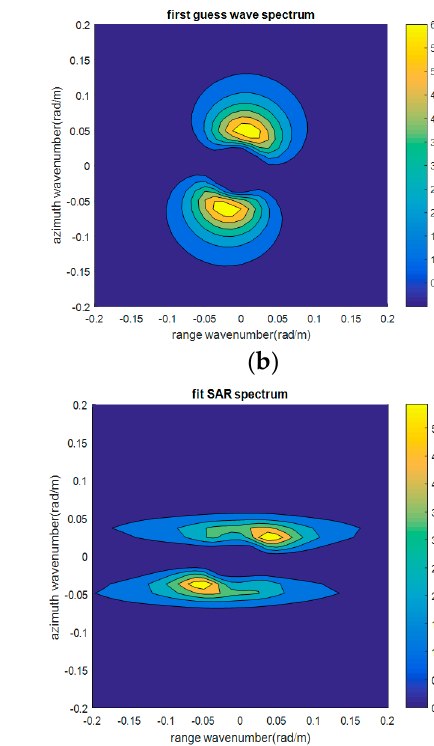
( d ) Figure 11. SAR-1 : Max Plank Institute (MPI) algorithm inversion results as follows: ( a ) Observed SAR spectrum (after horizontal flip), ( b ) first guess PM wave spectrum, ( c ) fit PM wave spectrum, and ( d ) fit SAR spectrum. As can be seen from the figures, the direction of wave propagation is consistent with the initial input angle. The first guess wave spectrum is in line with the magnitude and shape of the fit wave spectrum. The fit SAR spectrum is also consistent with the magnitude of the fit wave spectrum. The